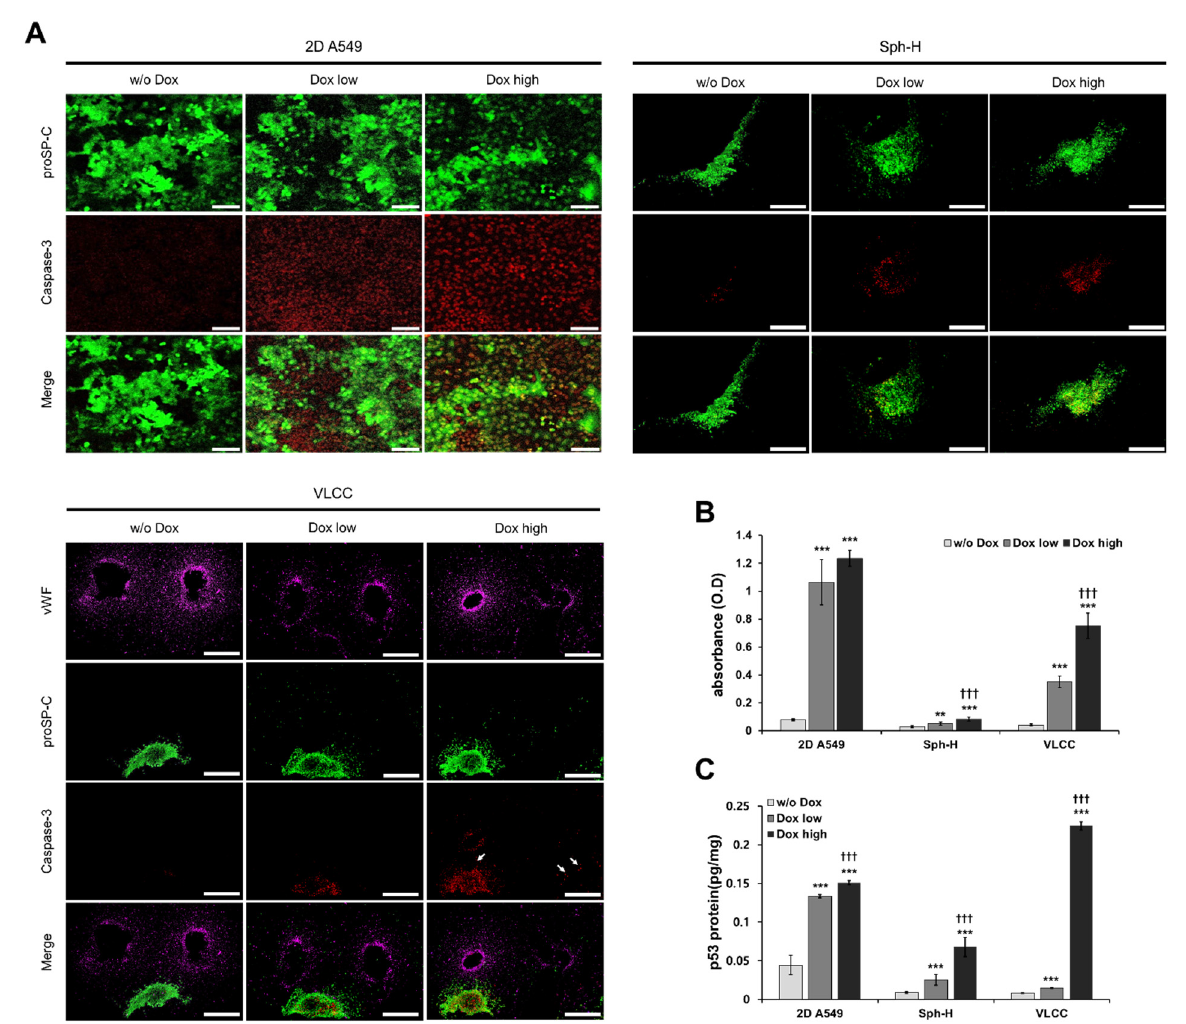
Figure 6. Evaluation of drug efficacy using Doxorubicin. ( A ) Representative immunofluorescence images of apoptotic cells on 2D A549, Sph-H, and the VLCC with different Dox doses. Scale bar: 100 µ M (2D culture), 500 µ M (Sph-H, VLCC). ( B ) Quantification of the cell death in 2D A549, Sph-H, and the VLCC with different Dox doses. ** p < 0.01, *** p < 0.005 compared with w/o Dox, ††† p < 0.005 compared with Dox low. ( C ) Quantification of the p53 protein level in 2D A549, Sph-H, and the VLCC with different Dox doses. *** p < 0.005 compared with w/o Dox, ††† p < 0.005 compared to Dox low.